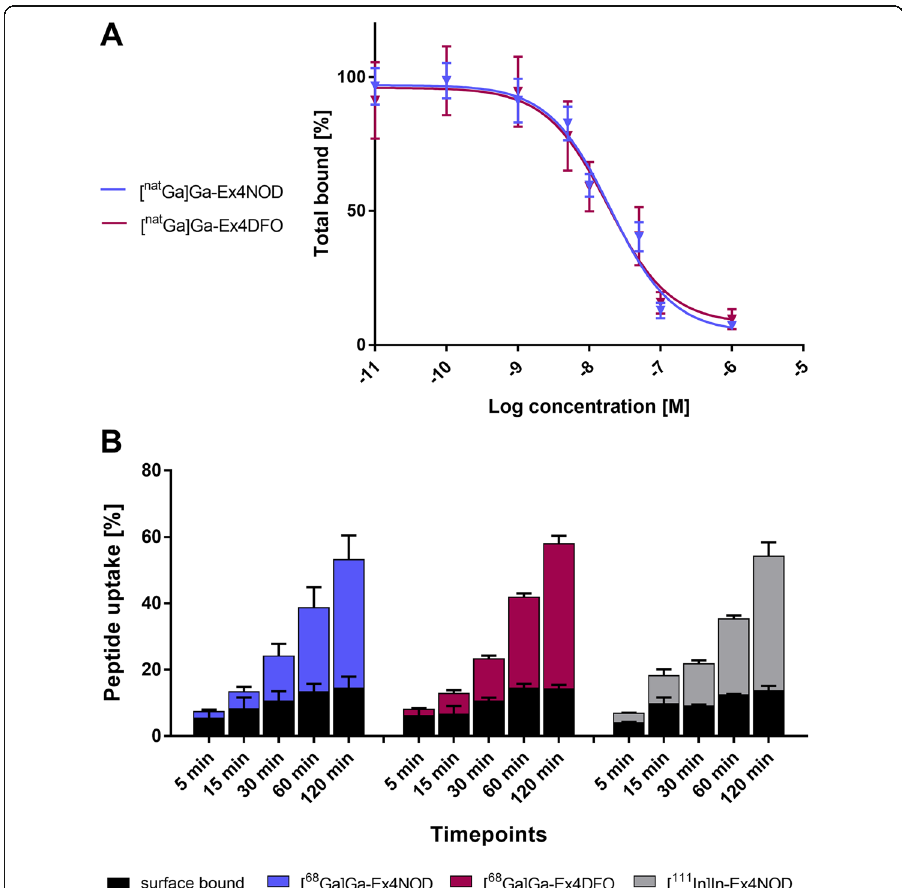
Fig. 1 In vitro characterization of Ex4NOD and Ex4DFO ( a ) The IC 50 curves of [ nat Ga]Ga-Ex4NOD and [ nat Ga]Ga-Ex4DFO, shown as the displacement of [ 111 In]In-Ex4NOD from the GLP-1 receptor on CHL cells, correspond closely. b The GLP-1R-mediated cell binding and internalization show similar time-dependent trend in both gallium-68 labeled peptides, which again in turn is comparable to indium-111 labeled peptide. The percentage represents total cell